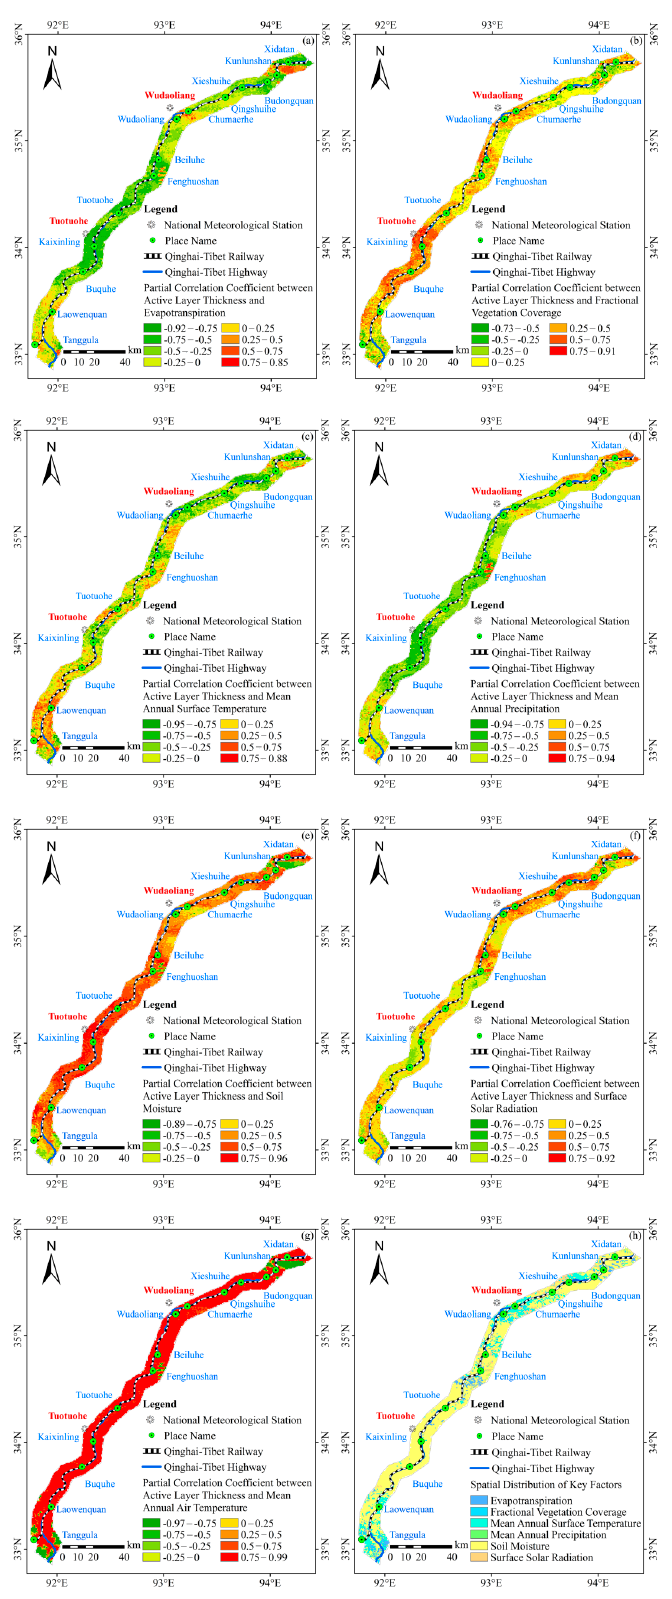
Figure 14. Spatial distribution of the partial correlation coefficient between ALT and driving factors, and key factors affecting ALT: ( a ) ET; ( b ) FVC; ( c ) MAST; ( d ) MAP; ( e ) SM; ( f ) SR; ( g ) MAAT; ( h ) key factors.